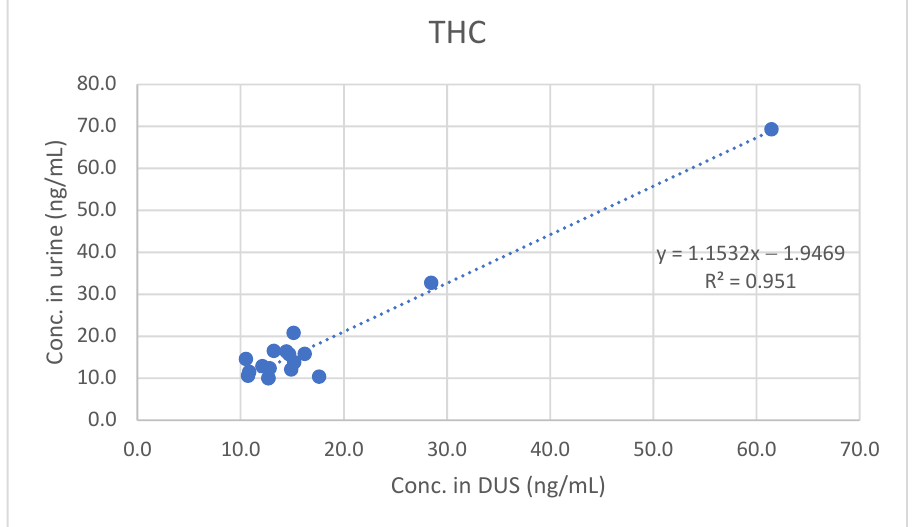
Figure 1. Comparison between urine and DUS concentrations of THC.